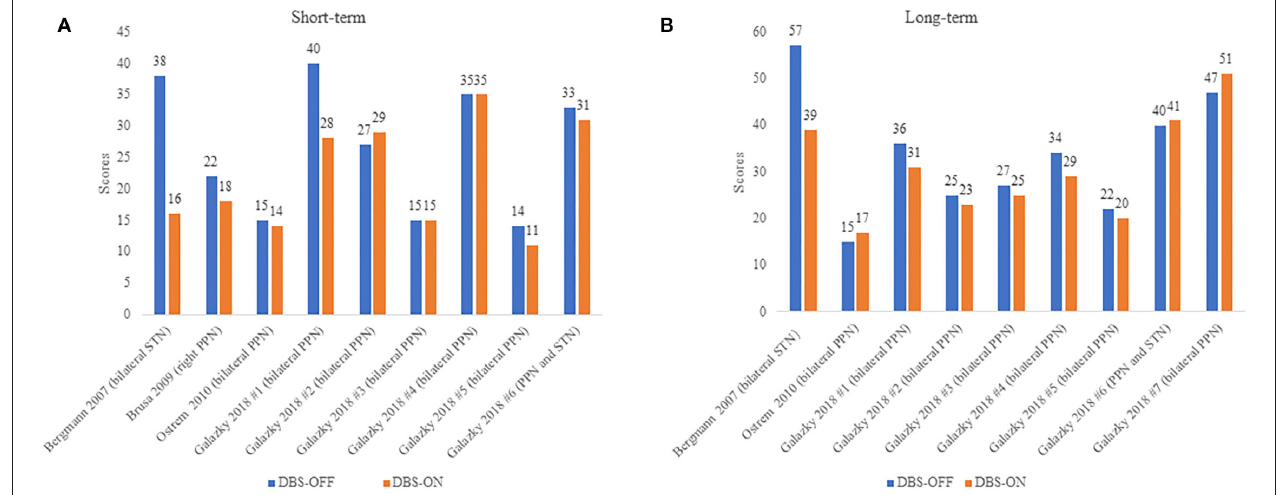
FIGURE 2 | (A,B) UPDRS III scores in PSP patients under DBS-OFF and DBS-ON status. Short-term: < 12 months after DBS, long-term: more than or equal to 12 months after DBS. The words in brackets are DBS targets of each patient. analysis in short-term follow-up of patients presenting as PSP- RS, PSP-P, and PSP-PGF. As Table 2 shows, complete data were available in nine PSP cases from four studies (21, 37, 38, 41),